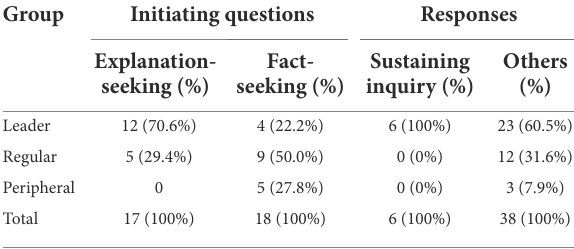
TABLE 7 Discussion forum question and response types by participation group. Group